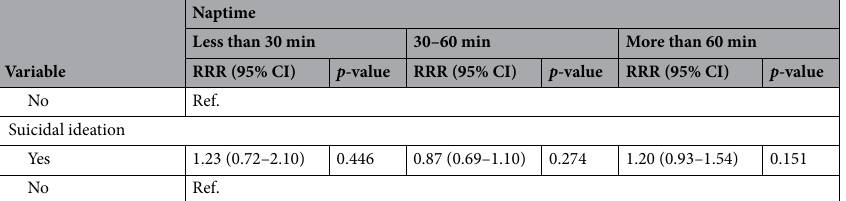
Table 5. Multinomial logistic regression between the study variables and naptime. RRR, relative risk ratio; CI, confidence interval; No nap considered as base outcome.